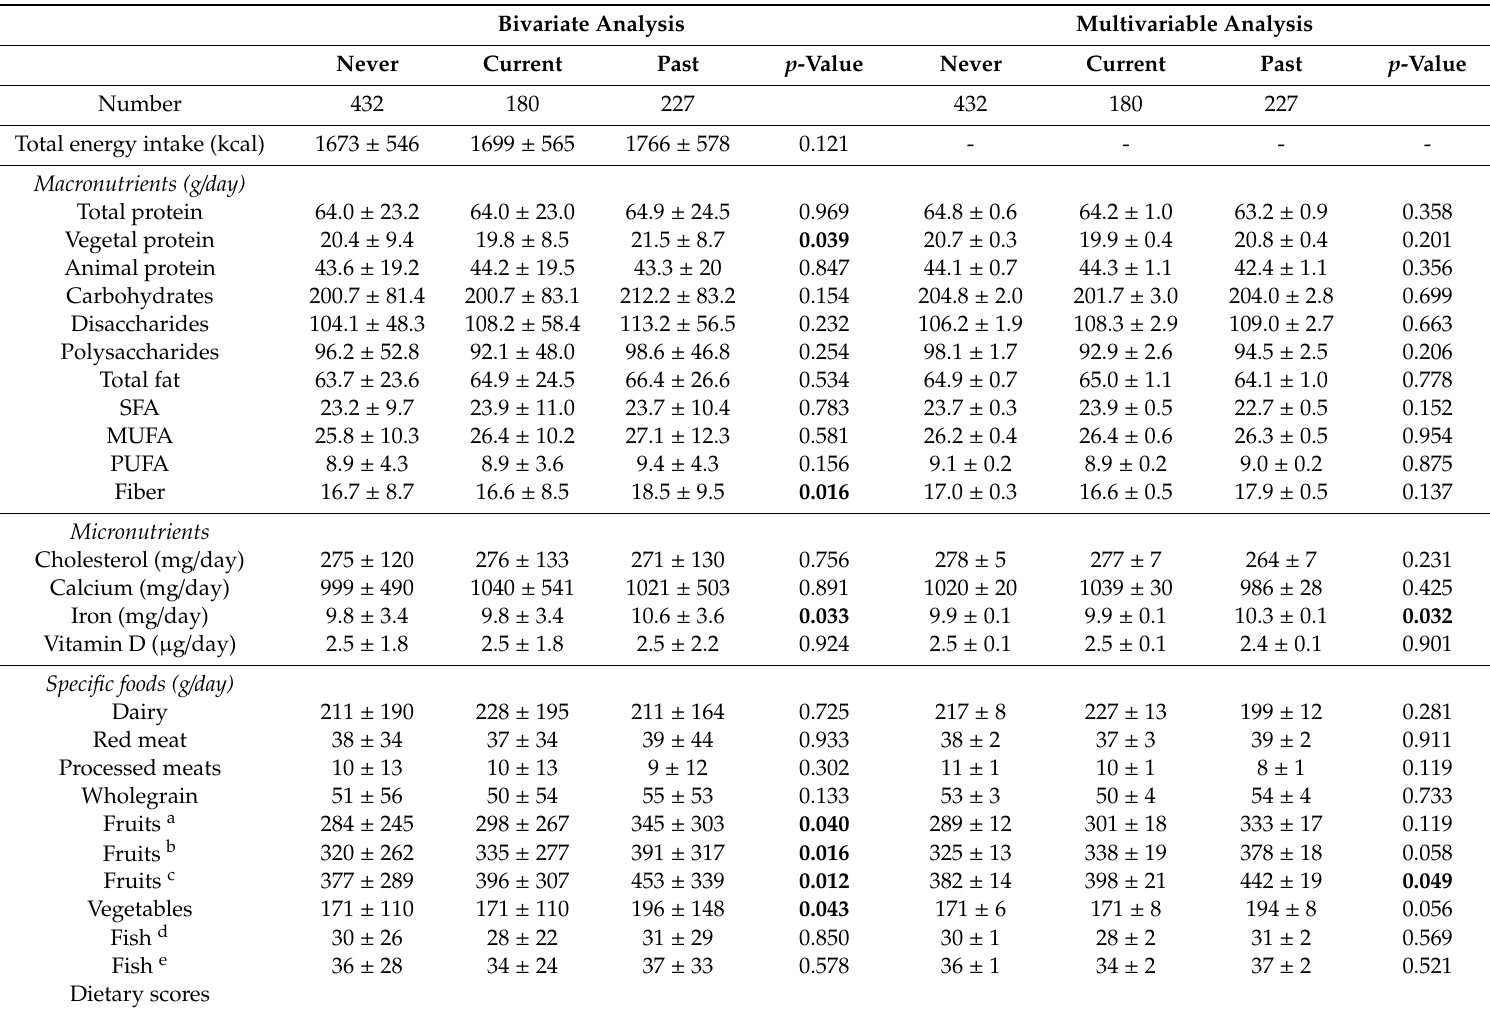
Table 2. Dietary intake according to menopausal hormone therapy. Bivariate